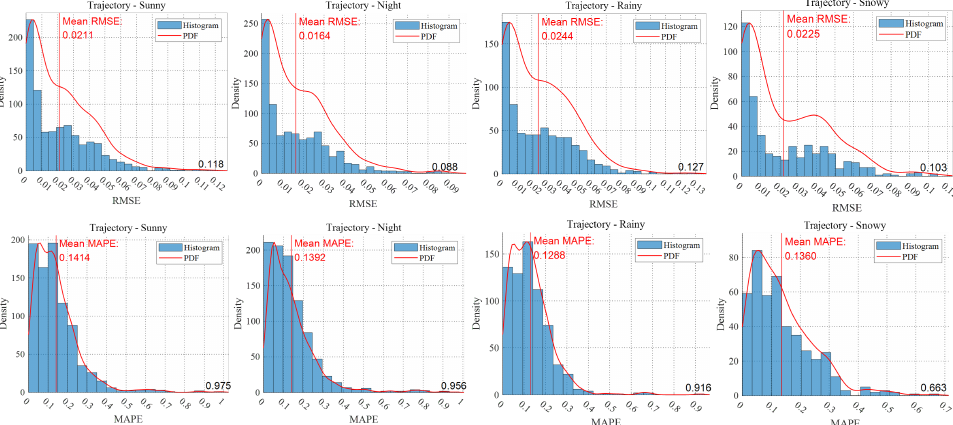
Figure 12. RMSE (first row) and MAPE (second row) histograms of extracted vehicle trajectories under four different weather conditions in the labeled MWUAV